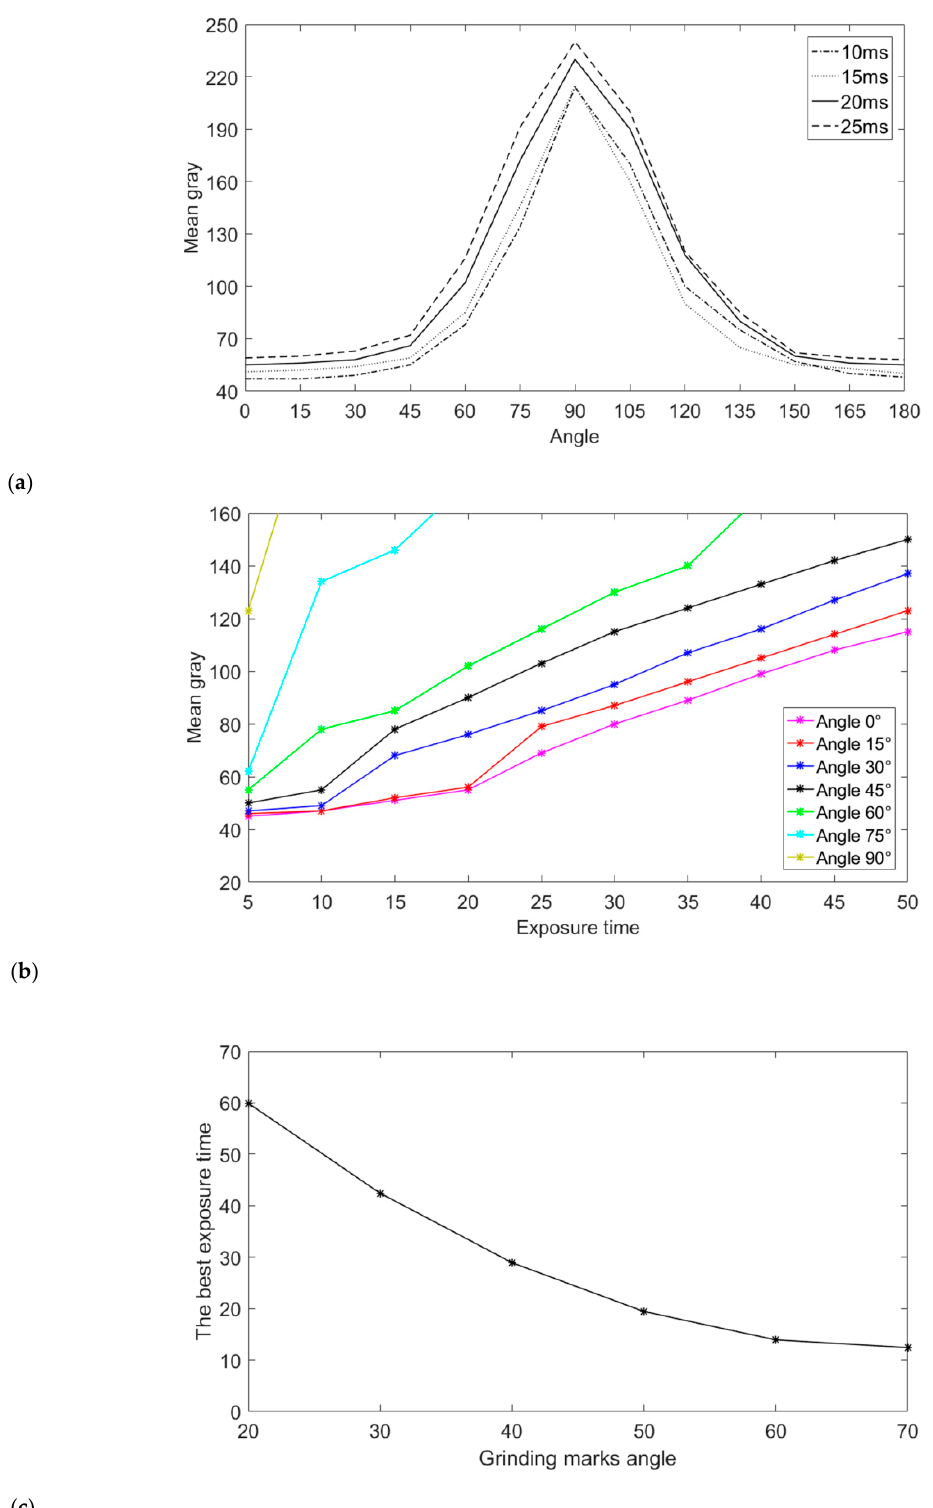
Figure 12. The data for selecting the best appropriate exposure time: ( a ) the relationship of angle and mean grayscale; ( b ) the relationship of exposure and mean grayscale; ( c ) the relationship of grinding marks angle and the best exposure time.